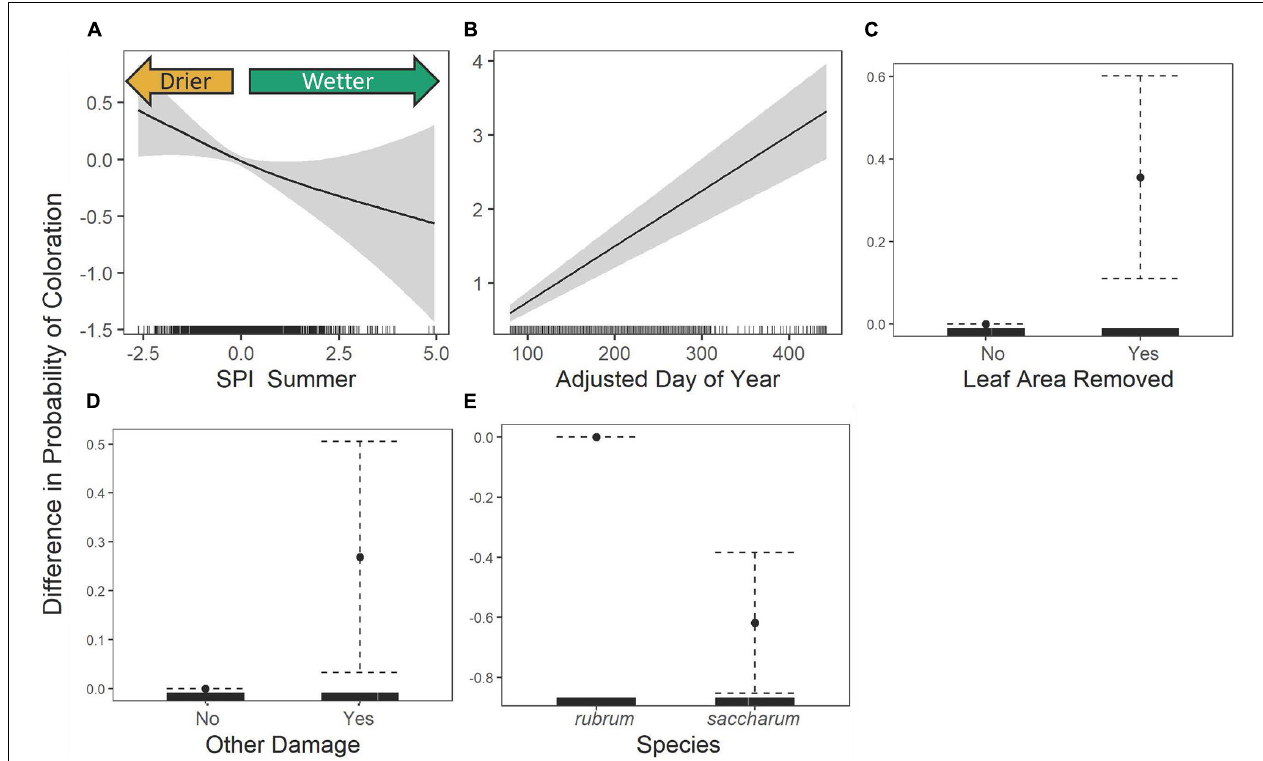
FIGURE 6 | The estimated contribution of General Additive Model SPI Summer (A) , the adjusted day of year (B) , leaf area removal (C) , other damage (D), and species (E) to the probability of colored leaves. The solid curve or point is the estimated contribution while the gray regions or dotted whiskers represent the 95% confidence interval, tick marks along the x-axis indicate the density of specimens. In figures (A,B) , the solid curve while the gray regions or dotted whiskers represent the 95% confidence interval and in figure (C–E) the solid point shows the estimated contribution while the dotted lines show the 95% confidence